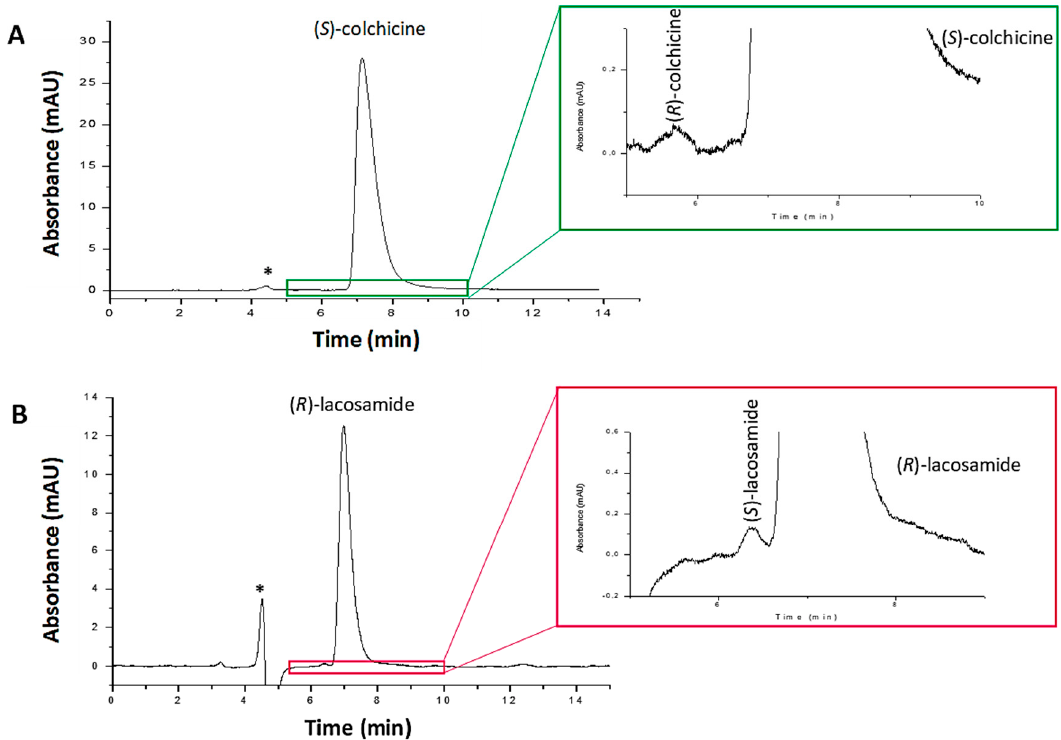
Figure 4. Chromatograms corresponding to ( A ) colchicine pharmaceutical formulation solution containing 1000 µ g / mL of ( S )-colchicine and spiked with ( R )-colchicine standard (1.0 µ g / mL), and ( B ) lacosamide pharmaceutical formulation solution containing 1700 µ g / mL of ( R )-lacosamide and spiked with ( S )-lacosamide standard (1.7 µ g / mL). Experimental conditions: mobile phase n -hexane / 2-propanol (80 / 20, v / v ) with 0.2% of diethylamine, capillary flow rate 200 nL / min, room temperature, λ : 210 nm (lacosamide) and 243 nm (colchicine). * Peak corresponding to the solvent signal.